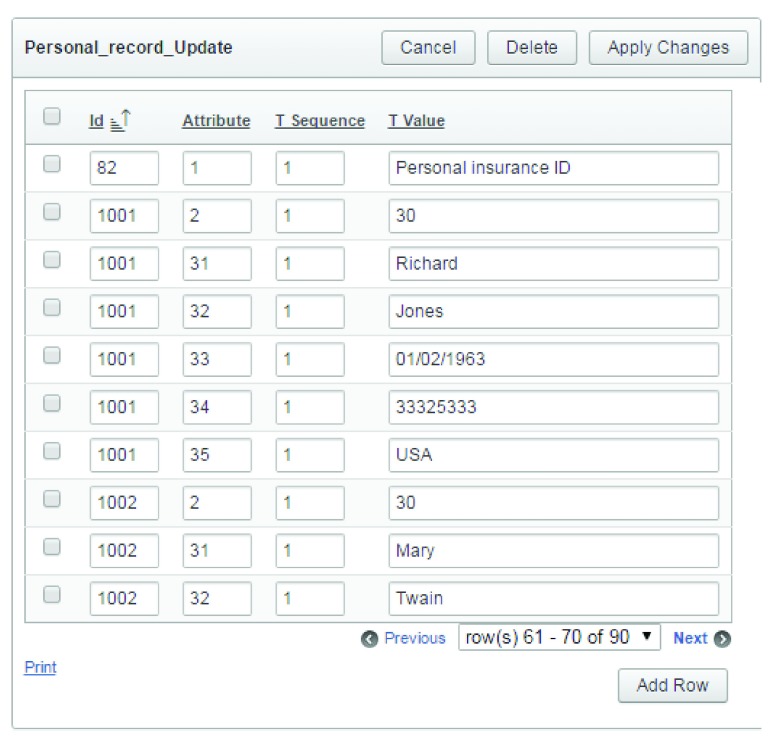
Attribute storage.